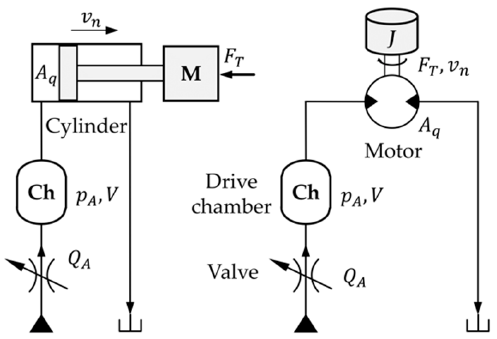
Figure 2. Simple model of hydraulic cylinder/motor.